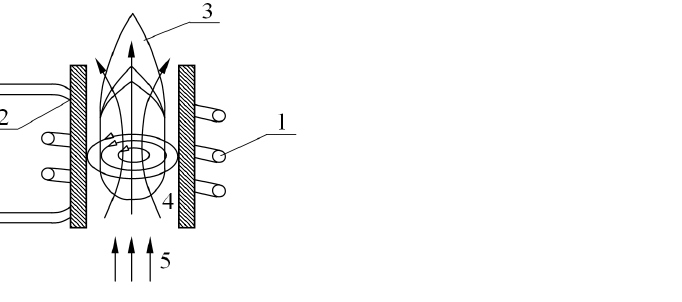
Figure 1. Schematic diagram of a high-frequency induction plasma torch: 1—inductor; 2—discharge chamber; 3—plasma jet; 4—discharge area; 5—gas flow.